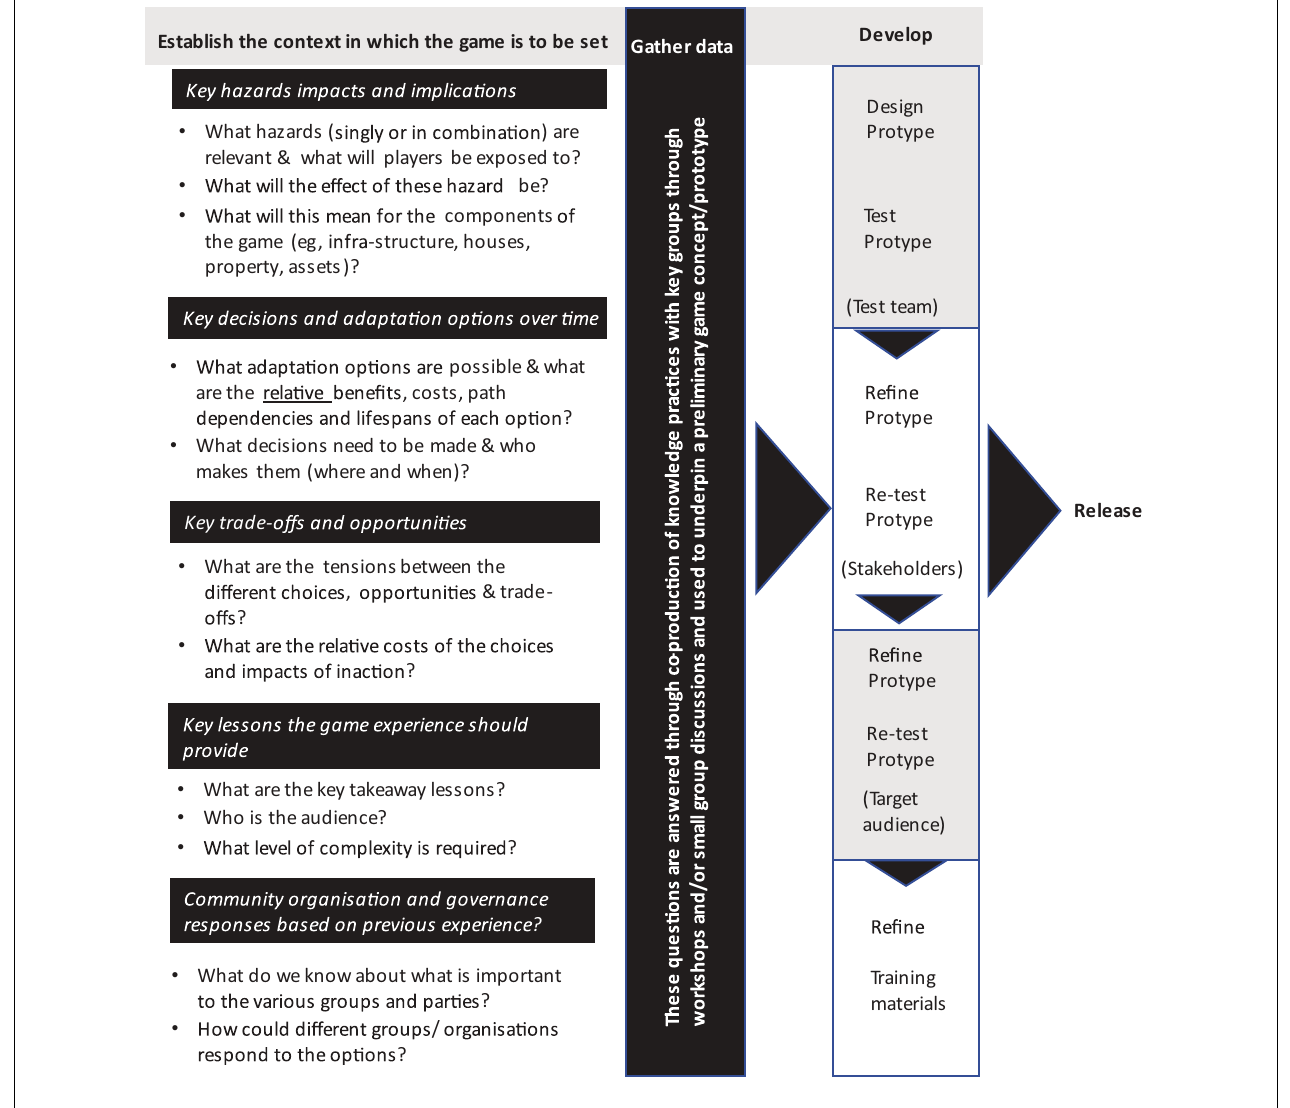
FIGURE 4 | Process for developing and testing serious games.